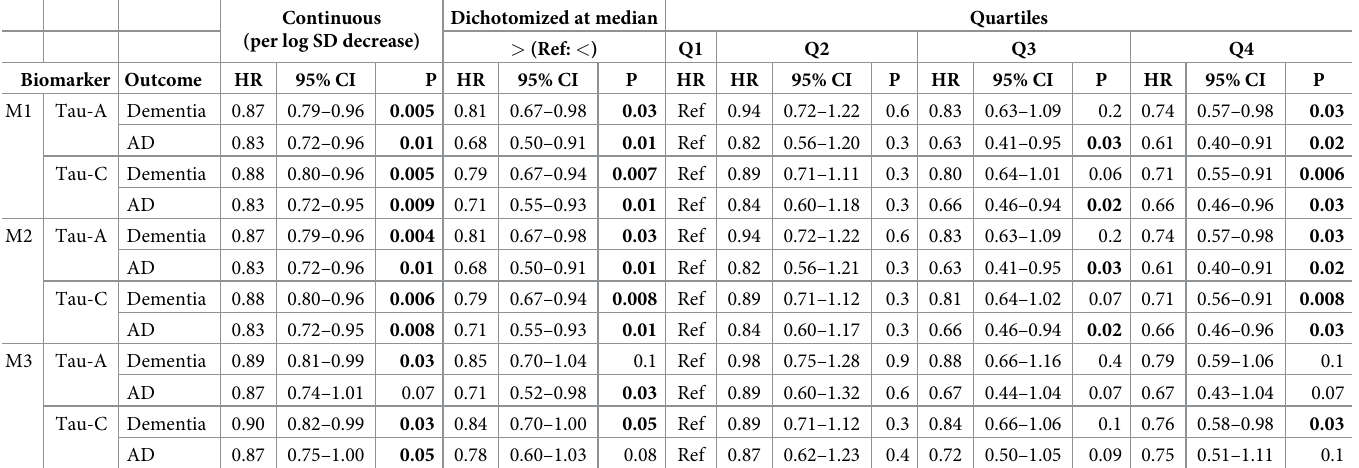
Table 2. Association of Tau-A and Tau-C with the risk of incident dementia and Alzheimer’s